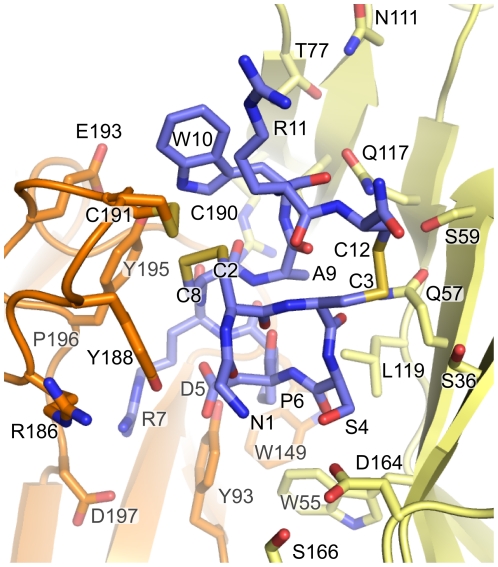
Analysis of the binding mode of ImI to the α7-nAChR.The structure of the binding pocket occupied by ImI after molecular dynamics simulation is displayed and positions discussed in the text are highlighted. The α7 principal subunit is in orange, the α7 complementary subunit is in pale yellow, and ImI is in violet. Nitrogens are in blue, oxygens are in red and sulfurs are in yellow.